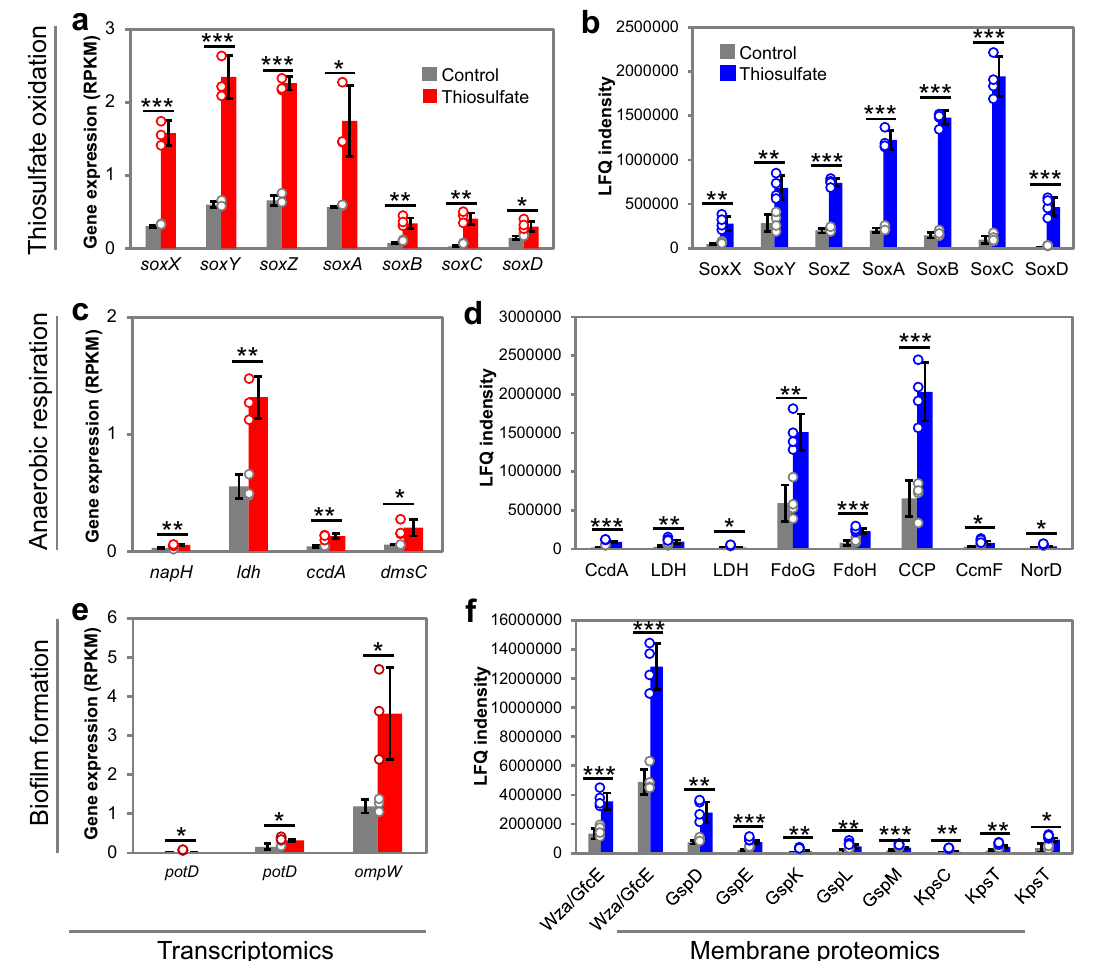
Fig. 5 | Transcriptomics and membrane proteomics analyses of the M382 bio- fi lm in response to thiosulfate. Genes or proteins associated with thiosulfate oxidation ( a transcriptomics; b membrane proteomics), anaerobic respiration ( c transcriptomics; d membrane proteomics), and bio fi lm formation ( e transcriptomics; f membrane proteomics) areshown. Full names ofgenes inthe transcriptomicsresults: napH ,ferredoxin-typeprotein; ldh ,lactatedehydrogenase; ccdA , cytochrome c-type biogenesis protein; dmsC , anaerobic dimethyl sulfoxide reductase subunit C; potD , spermidine/putrescine transport system substrate- binding protein; ompW , an outer membrane protein. Full names of proteins in the proteomics results: CcdA, cytochrome c-type biogenesis protein; Ldh, lactate dehydrogenase; FdoG, formate dehydrogenase major subunit; FdoH, formate dehydrogenase iron-sulfur subunit; CCP, cytochrome c peroxidase; CcmF, cyto- chrome c-type biogenesis protein; NorD, nitric oxide reductase. Wza or GfcE,